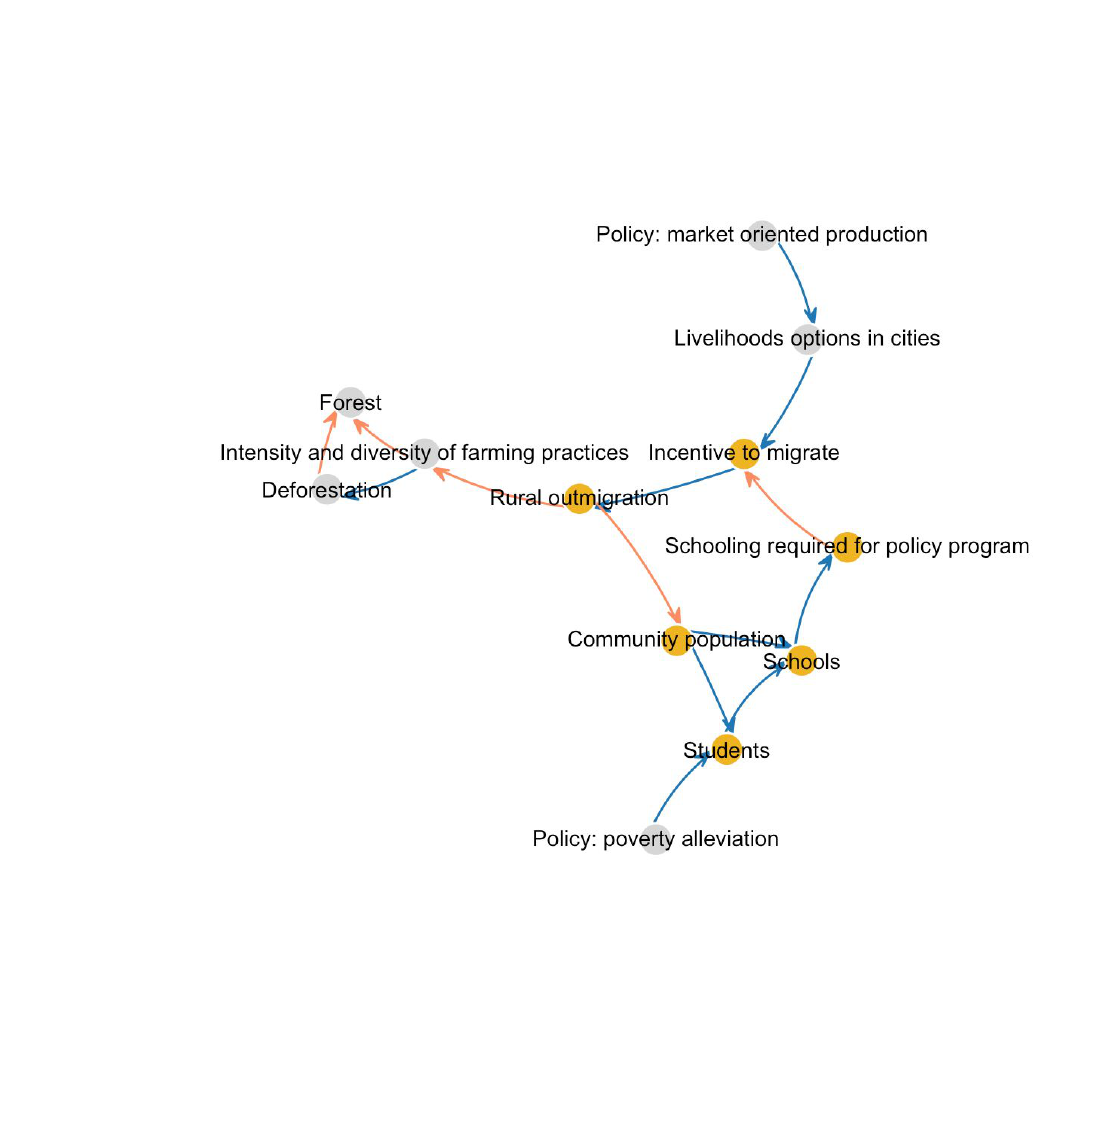
Figure A1.4. CLD rural out-migration and farm abandonment in the Pará, ​​